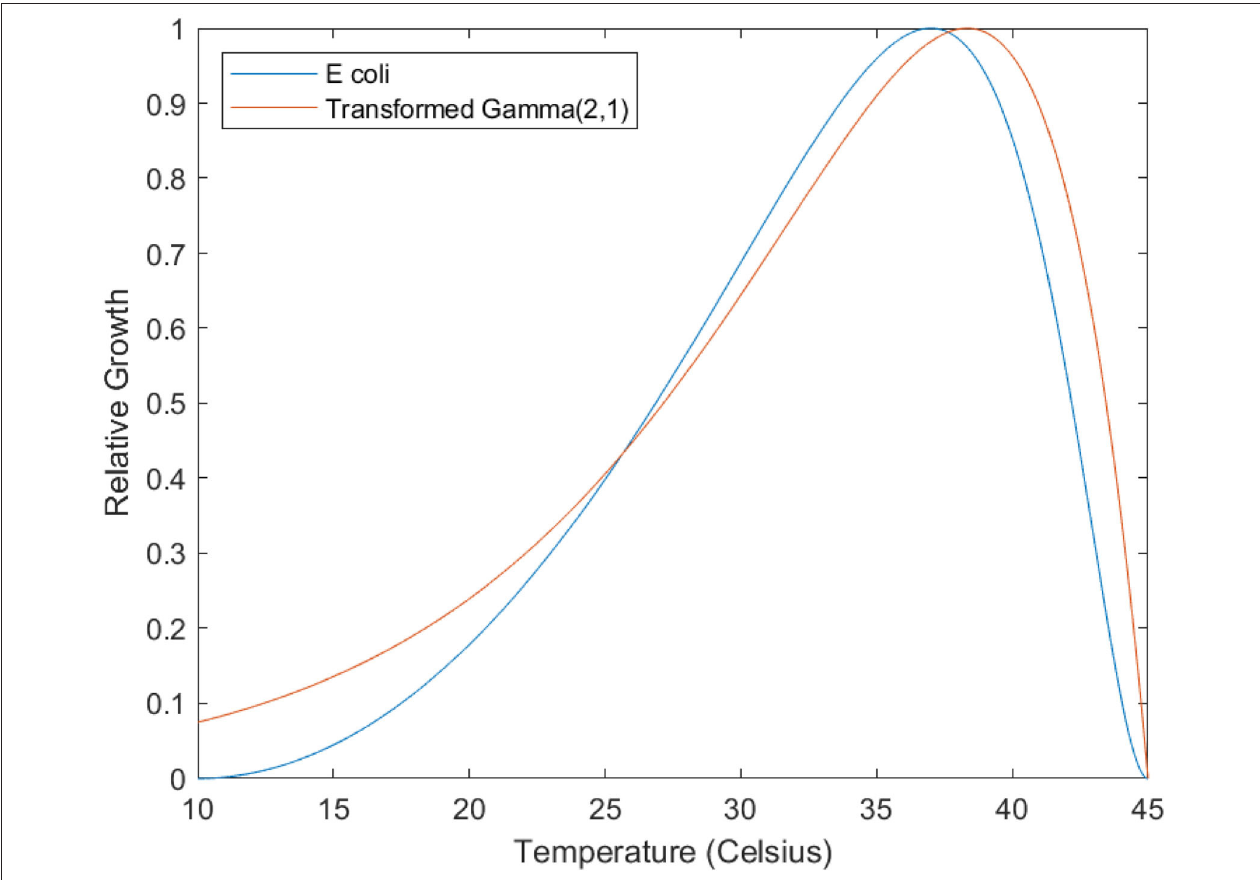
FIGURE 4 | Illustrating similarity between Ratkowsky equation and Gamma distributions. The blue line is the modelled growth curve for E Coli (see Equation 4). The red line is a reflected, scaled, and stretched Gamma (2,1) distribution, the equation being